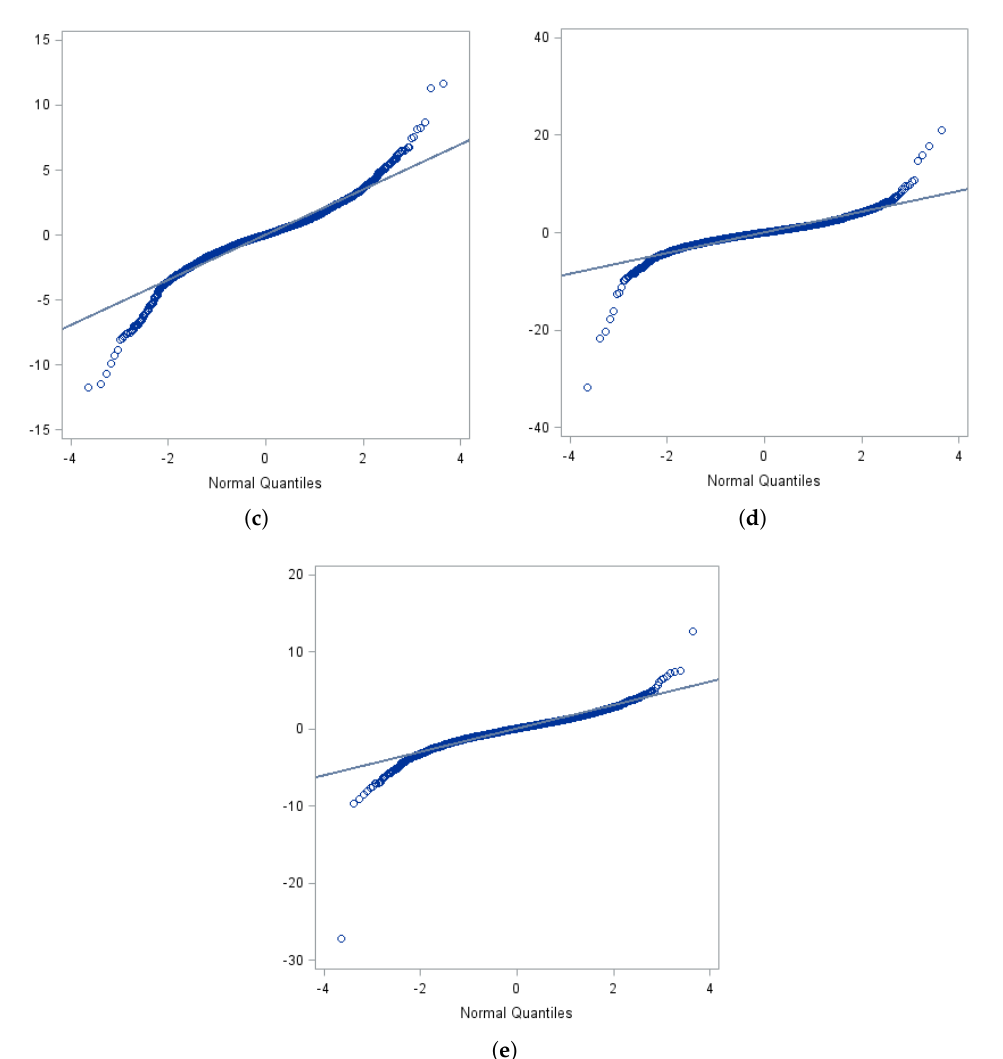
Figure 1. Quantile–quantile plots for the heavy metal price returns. ( a ) Gold price returns. ( b ) Silver price returns. ( c ) Copper price returns ( d ) Zinc price returns. ( e ) Platinum price